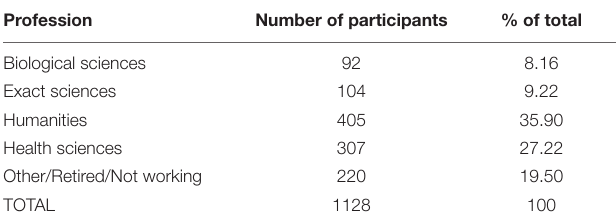
TABLE 3 | Number of participants in each profession and percent of total.